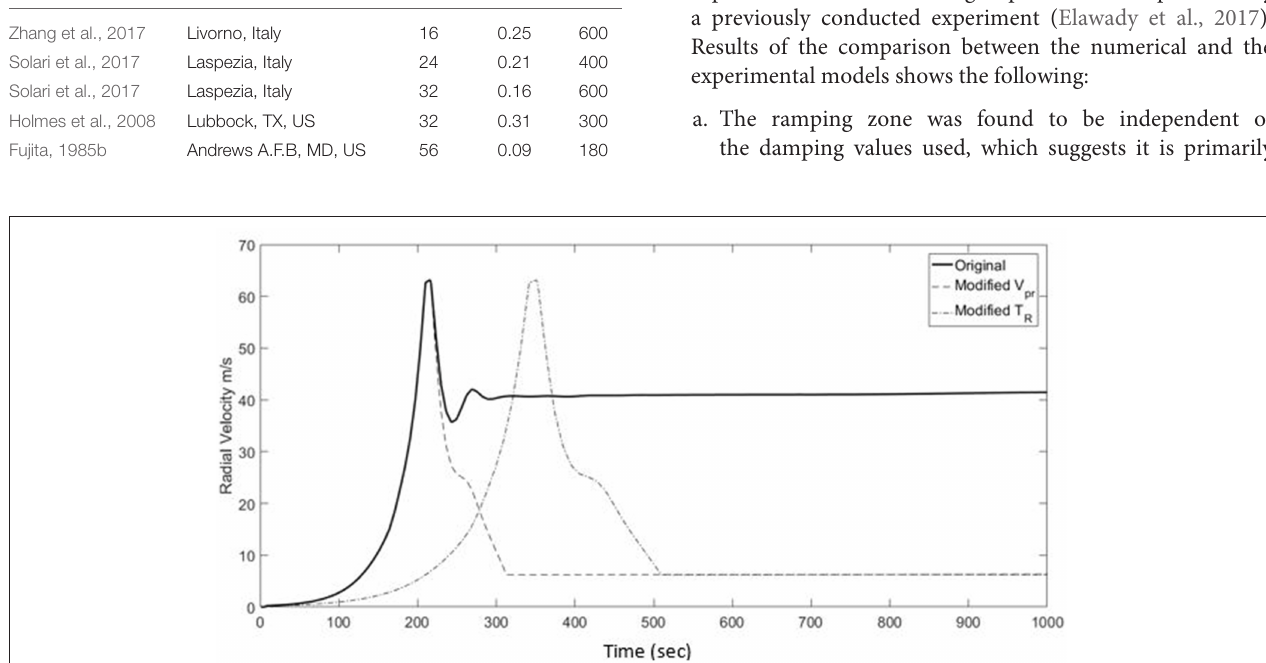
FIGURE 12 | Modified time histories of radial